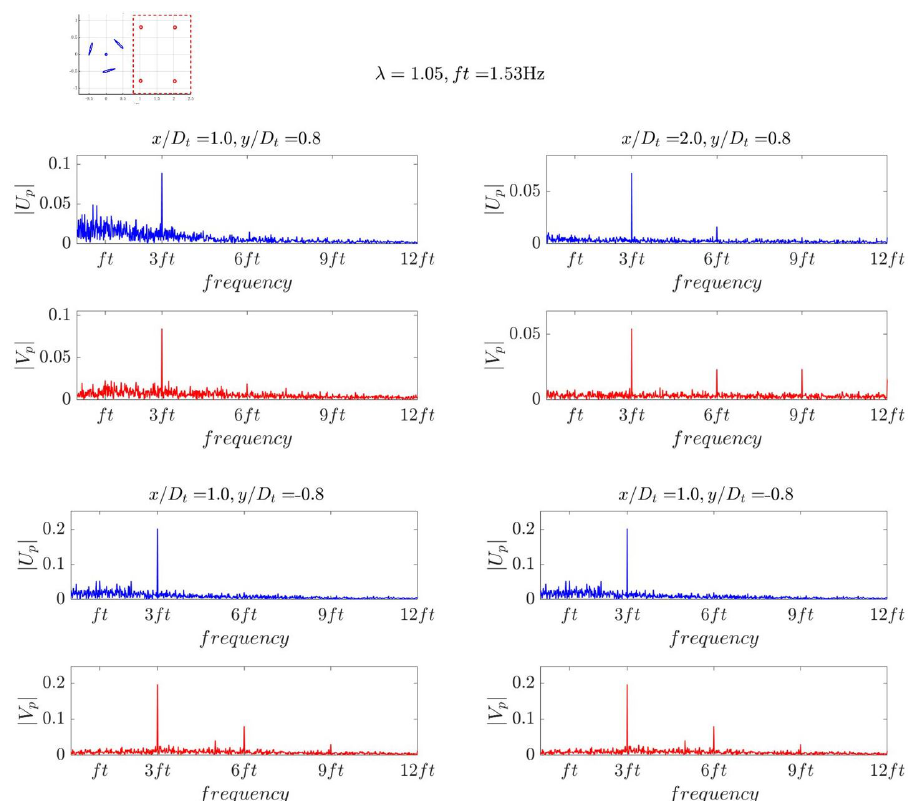
Figure 8. The FFT analyses of the time series streamwise and transverse velocities at the 4 points, highlighted in Figure 5, in the near-wake of the T2 turbine configuration at λ =